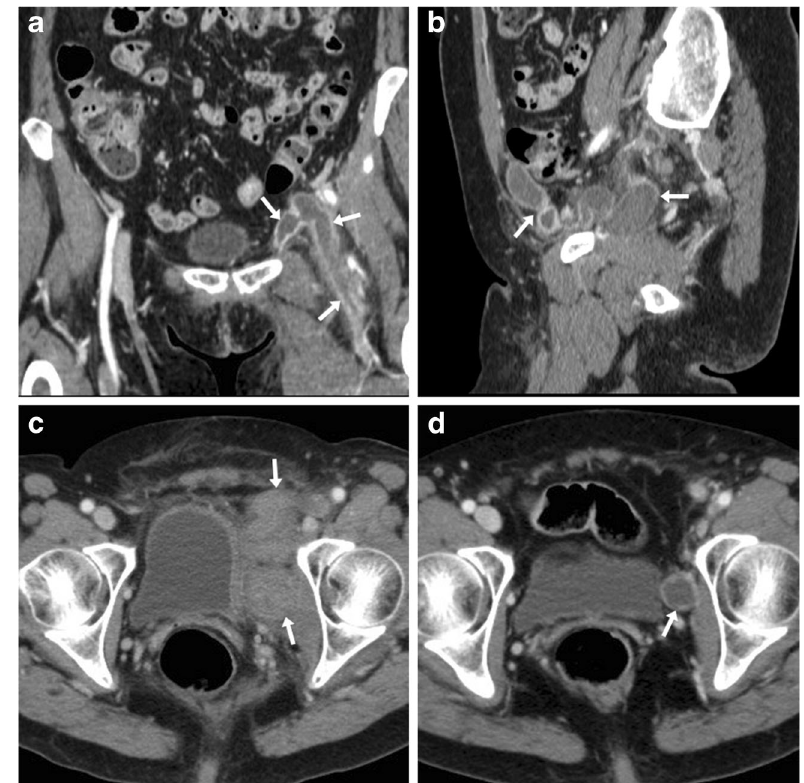
Fig. 9 Endovenous heat-induced thrombosis (EHIT) in a 55-year- old woman experiencing left- sided groin pain, tenderness and swelling three days after endovenous laser ablation of the ipsilateral small saphenous vein. Multiplanar contrast-enhanced CT images (A, B) panoramically showed the full extent of iliac- femoral EHIT including the ipsi- lateral inferior hypogastric and obturator veins, with mild dilata- tion, luminal non-opacification and prominent enhancement of venous walls (arrows). One week later, repeated CT (C) showed persistent thrombosis of proximal femoral and obturator veins with disappeared mural enhancement (arrows) and increased mass ef- fect on the urinary bladder. Follow-up CT three months later (D) showed recanalisation of the left femoral vein and persistence of chronic obturator vein throm- bosis [Adapted from Open Access ref. no. [38]]